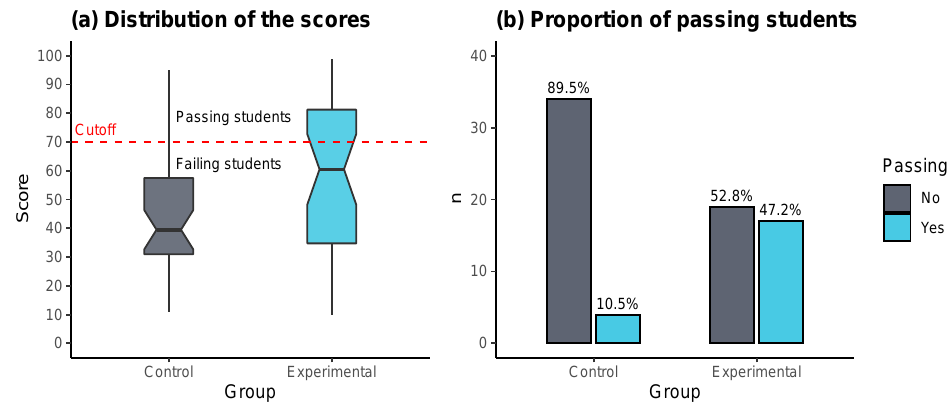
Figure 4. Distribution of the scores achieved by the students in the midterm exam ( a ) and proportion of passing and failing students ( b ). A student is considered to pass when the corresponding score is greater than or equal to 70 (this cutoff is represented by the red dashed line in plot ( a )).